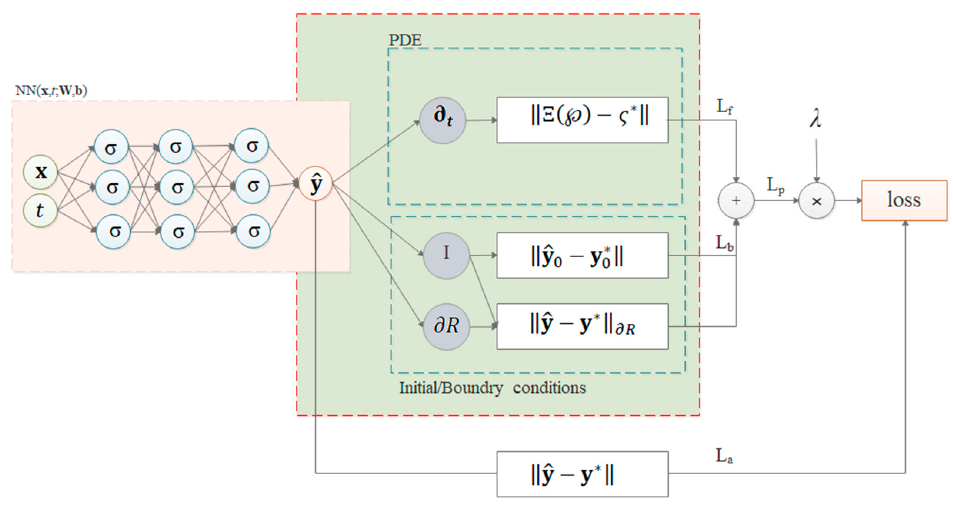
Figure 1. PINN schematic algorithm for loss function.